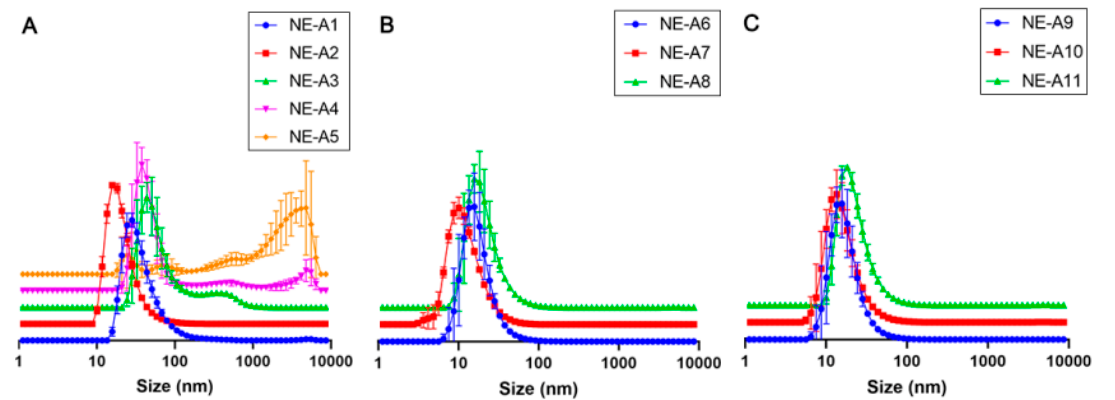
Figure 1. Mean droplet size (nm) distribution curves of the ultrasonically prepared nanoemulsions: ( A ) NE-A1 to NE-A5, ( B ) NE-A6 to NE-A8, and ( C ) NE-A9 to NE-A11.